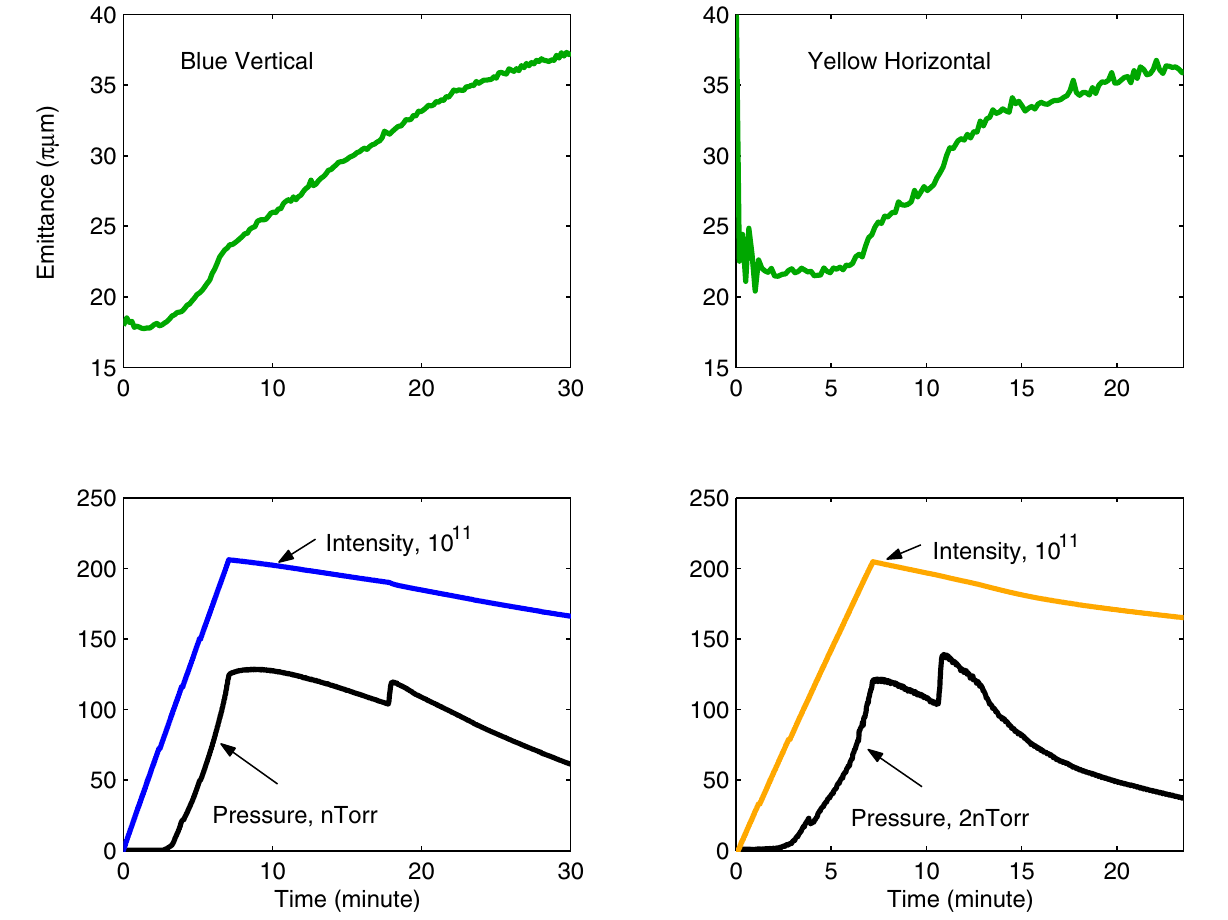
FIG. 3. (Color) Blue ring vertical and Yellow ring horizontal emittance growth observed by IPM for high intensity beams injection, followed by increasing rf voltage. The vacuum pressure is the average taken over 4 long straight sections with highest pressure rise in given